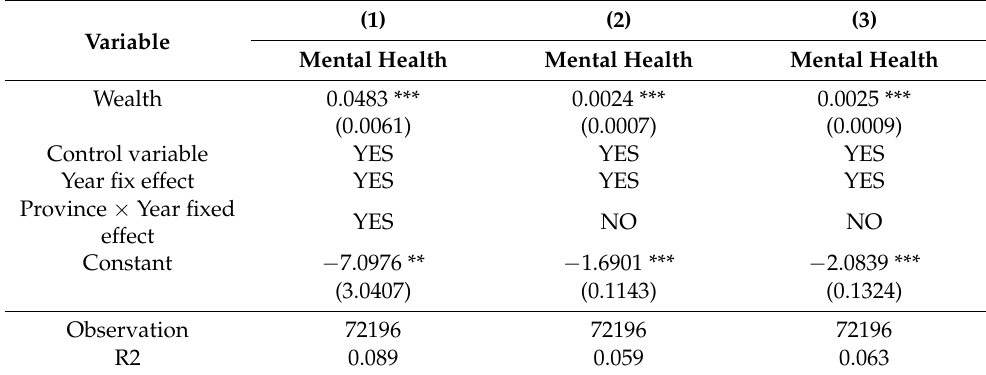
Table 4. Results of the robustness